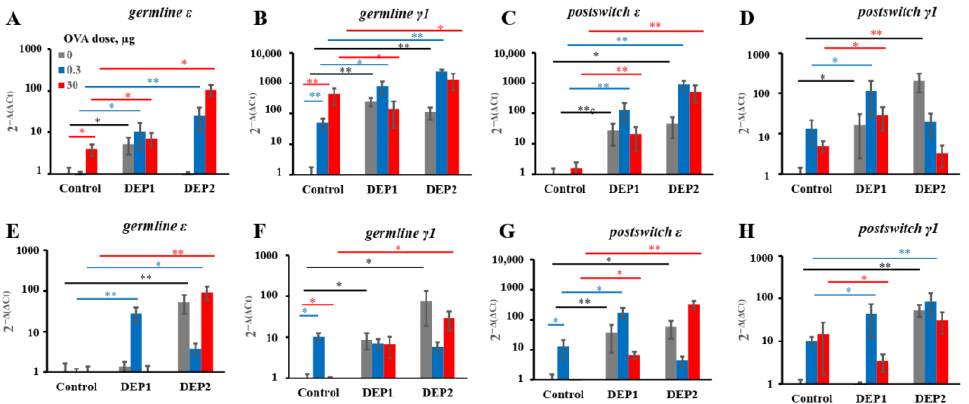
Figure 4. Expression of transcripts corresponding to B-cell Ig class switching and antibody production in lung tissue and regional lymph nodes. BALB/c mice were immunized 2–3 times a week for eight weeks (a total of 18 immunizations) via the i.n. route without OVA (Saline), with a low (0.3 µg) OVA dose or high (30 µg) OVA dose, without particles (control), or with either DEP1 or DEP2 in high (150 µg) dose. After immunization, the mice were sacrificed. The expression of transcripts corresponding to IgE ( germline ε ) ( A , E ) and IgG1 ( germline γ1 ) ( B , F ) class switching, as well as transcripts corresponding to mature IgE ( postswitch ε ) ( C , G )- and IgG1 ( postswitch γ1 ) ( D , H )-producing cells were measured in lung tissue ( A – D ) and regional lymph nodes ( E – H ). Black bars indicate significant (* — p < 0.05; ** — p < 0.01) differences between mice immunized without OVA with different DEPs and the respective control without DEPs; green bars indicate significant differences between mice immunized with low OVA doses with or without DEPs and the respec- tive control groups; red bars indicate significant differences between mice immunized with high OVA doses with or without DEPs and the respective control groups. The experiment was per- formed three times. The graphs show the data from three representative experiments (total number of mice included in analysis from all experiments n = 6 per group). The data indicate biological replicates obtained from individual mice.